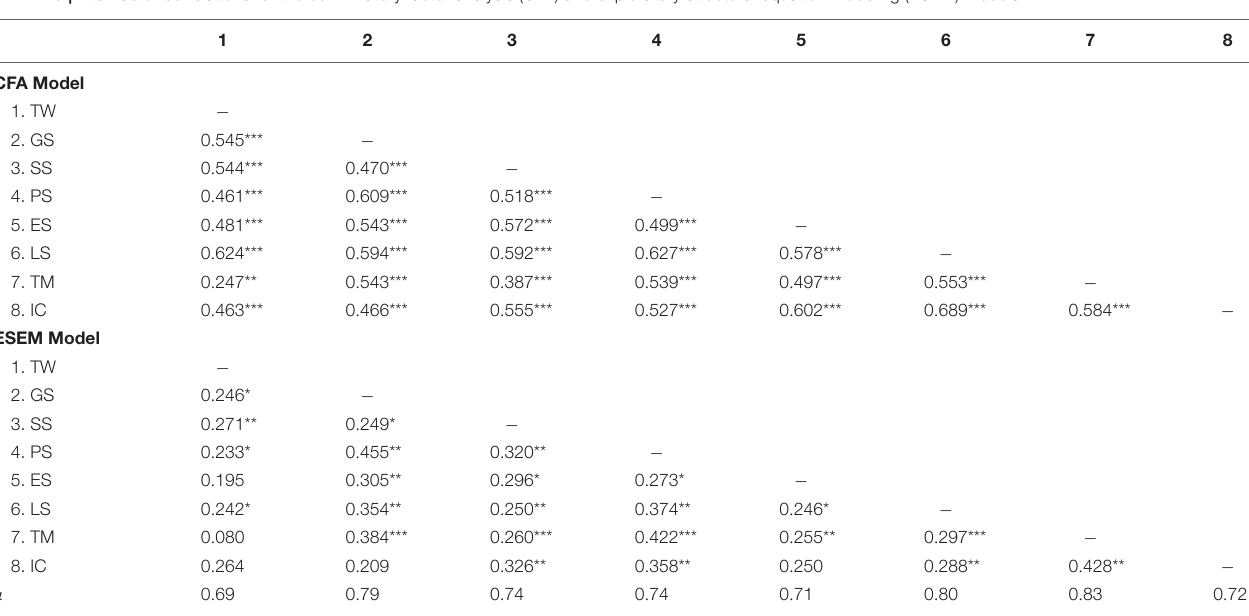
TABLE 3 | Inter-factor correlations for the confirmatory factor analysis (CFA) and exploratory structural equation modeling (ESEM)